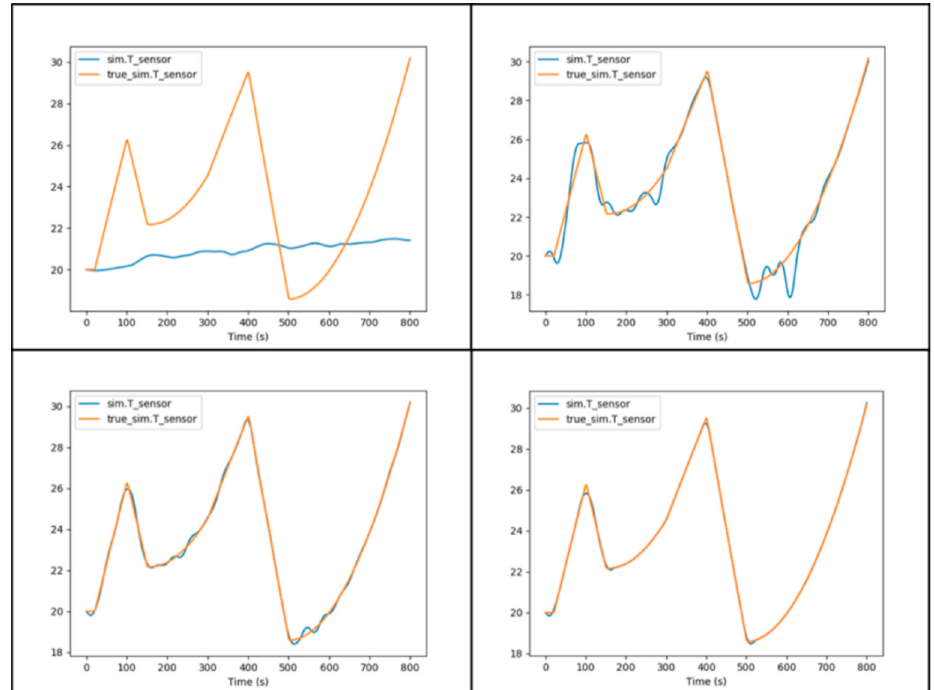
Figure A2. Progress in matching temperature on the opposite side of the wall, where orange is the desired temperature response and blue is the simulated response of optimized heat flux input.